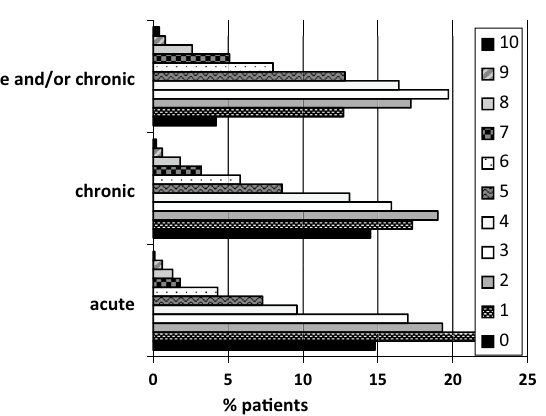
Figure 3. Percentage of patients with acute and chronic diseases according to the number of affected body systems